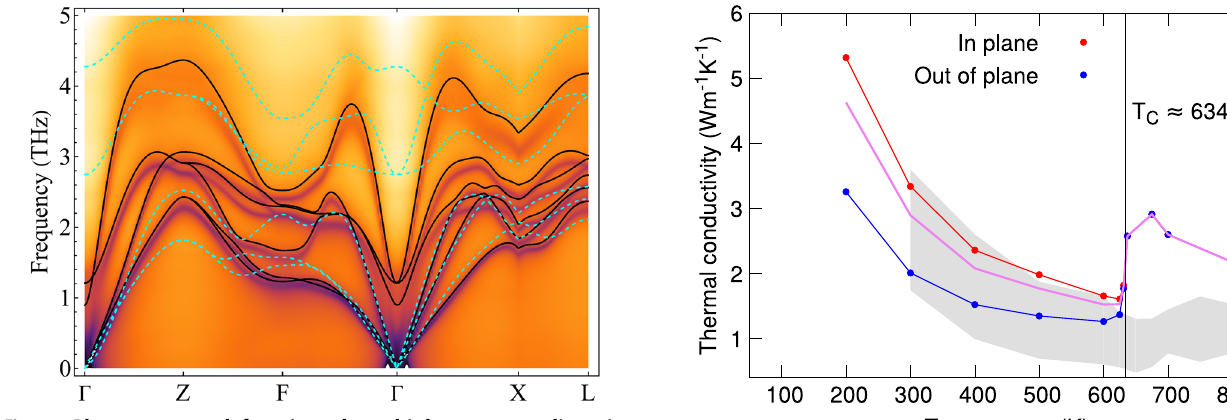
Fig. 2 Phonon spectral function along high symmetry lines in GeTe at the phase transition. The spectral function is calculated using Eq. (2). Black lines represent the temperature-dependent effective potential (TDEP) frequencies calculated at 631 K (close to the critical temperature 634 K) and dashed cyan lines are the TDEP phonon band structure at 300 K. The yellow colour corresponds to the lower, while the purple colour corresponds to the higher value of the phonon spectral function.